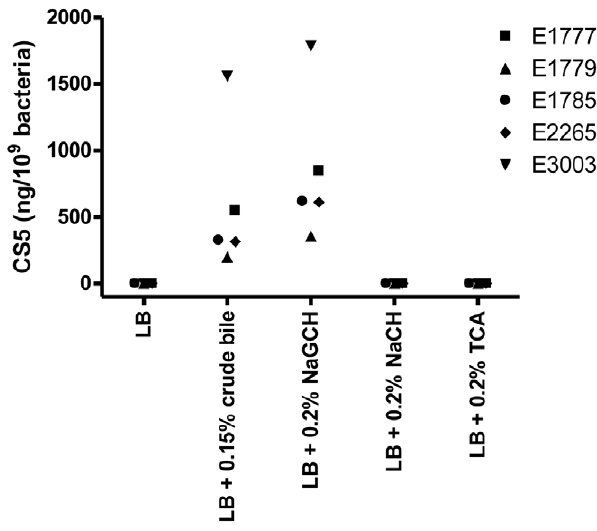
Figure 3. Phenotypic CS5 levels in LB alone and LB supple- mented with bile or individual bile salts. CS5 expression was quantified by inhibition ELISA after overnight culture to stationary phase of strains E1777, E1779, E1785, E2265, and E3003. CS5 surface expression tifwas induced by NaGCH, but not by the corresponding unconjugated bile salt NaCH or its tauro-conjugated counterpart TCA (representative data).